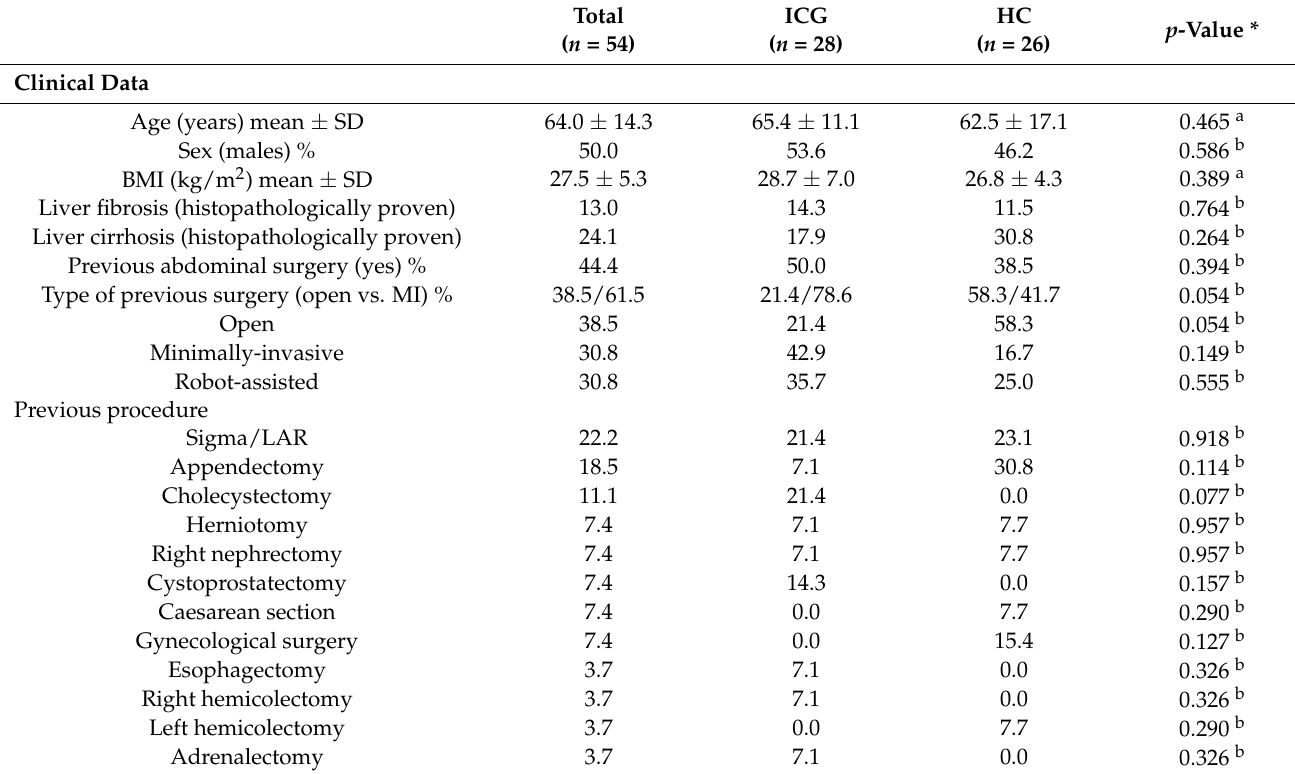
Table 1. Demographic baseline comparison of patients who underwent RALS with and without obtaining preoperative intravenous ICG. Total